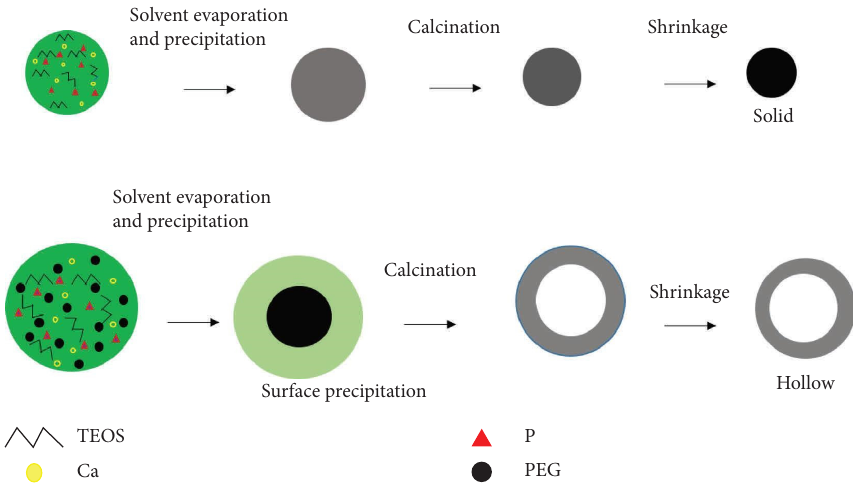
Figure 7: Formation mechanism of pure BG and PEG-derived-BG